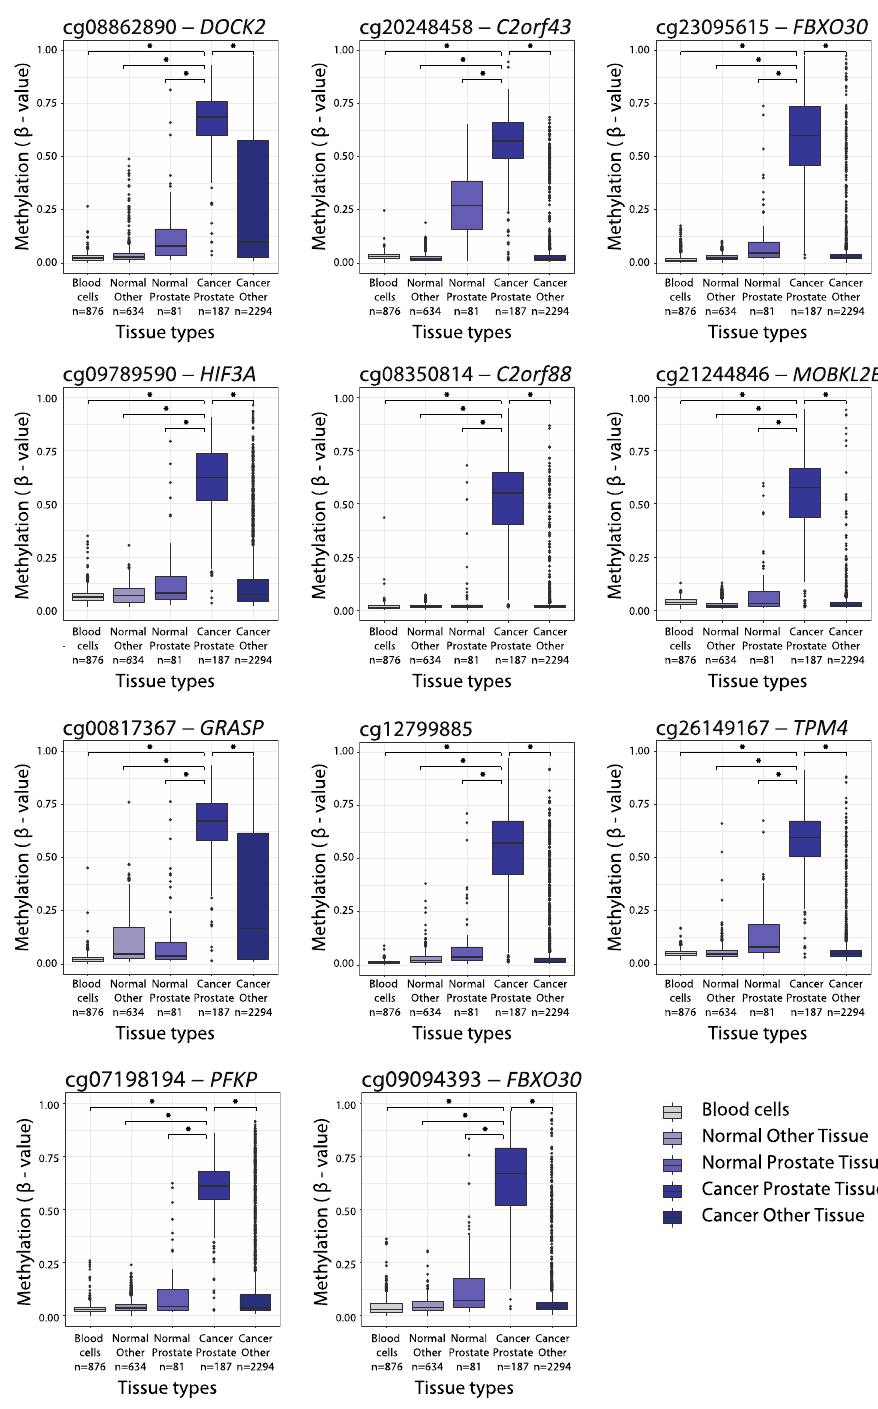
Figure 3. Methylation levels (ß-values) for the 11 selected biomarker candidates in the blood cell samples ( n = 876), normal prostate tissue samples ( n = 81), other normal tissue samples ( n = 634), prostate cancer tissue samples ( n = 187) and other cancer tissue samples ( n = 2294). Other normal/cancer sample types included 14 different groups (AML (acute myeloid leukemia)/ALL (acute lymphoblastic leukemia), bladder, CNS (central nervous system), colorectal, head and neck, liver, lung, lymphoma, kidney, melanoma, pancreatic, sarcoma, stomach and thyroid). * p < 0.001 (Wilcoxon Mann–Whitney test). The colored boxes indicate the 25–75th percentiles and the black horizontal lines indicate the median. Top whiskers are the 3rd quartile + 1.5 interquartile range and the bottom whiskers are the 1st quartile – 1.5 interquartile range. Round dots indicate outliers.